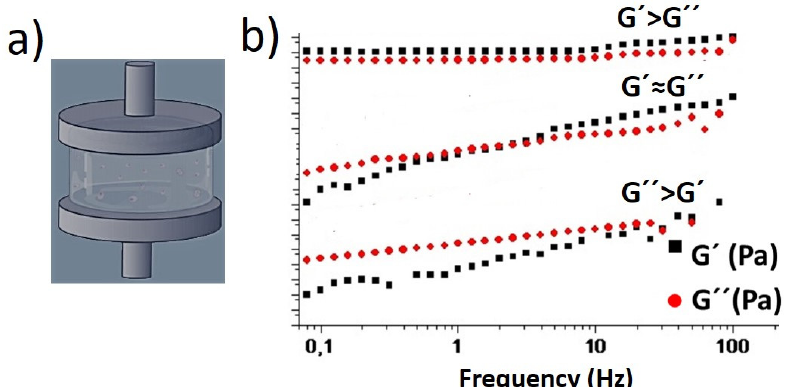
Figure 2. ( a ) Schematic representation of an experiment for the determination of G ′ and G ″ of hydrogels through shear rheometry. ( b ) Oscillatory frequency experiments performed on polymer hydrogels with different relaxation times starting from polymer solutions (with no crosslinks) to fully gel-like materials in which G ′ > G ″ . Adapted with permission from [33].